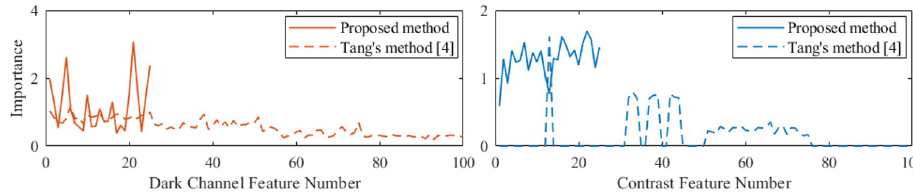
Figure 5. Comparison of the importance rate of each haze feature by random forest regression. The solid line represents the importance rate of the proposed method and the dotted line shows that of Tang’s method